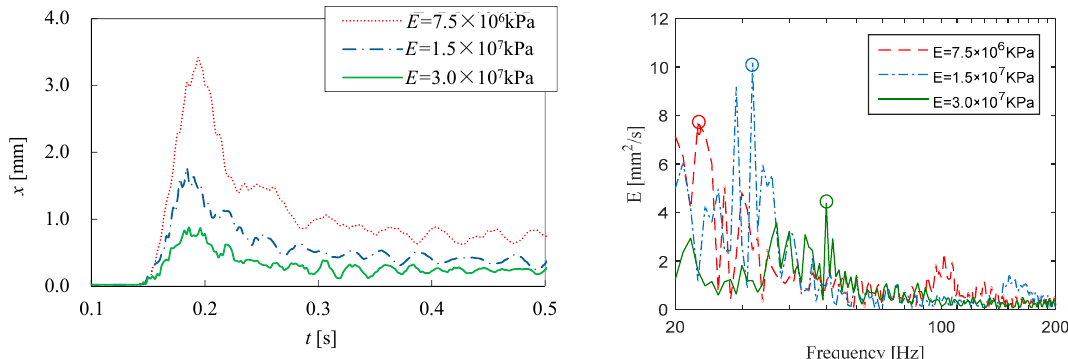
Figure 11. Horizontal displacement at the top of the structure under different structural stiffness.